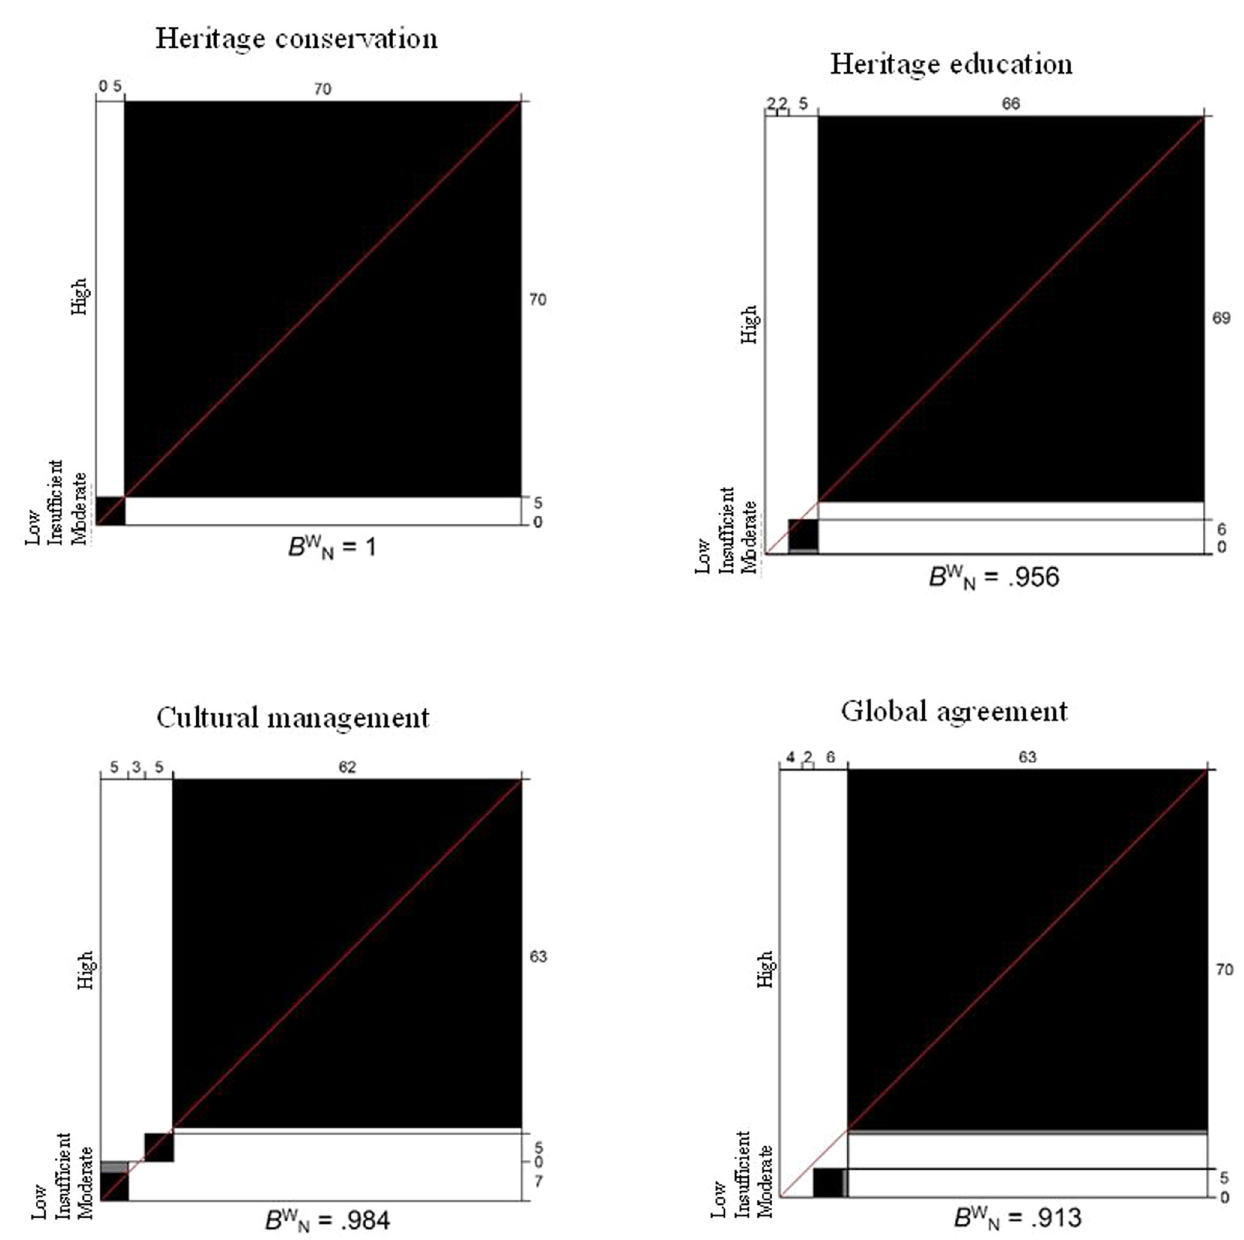
Fig. 1 Bangdiwala intra-group agreement diagrams and global agreement. Bangdiwala weighted coef fi cients of concordance ( B W N